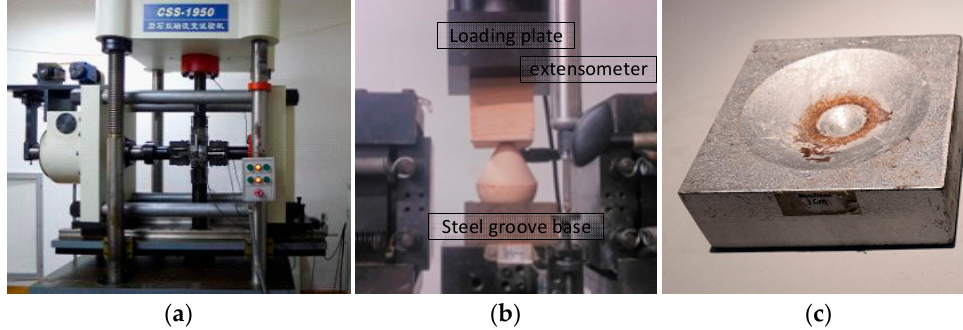
Figure 5. Experimental instruments and normal contact: ( a ) rock rheological testing system; ( b ) normal contact; ( c ) steel groove base. Table 2. Particle groups used in the experiments.